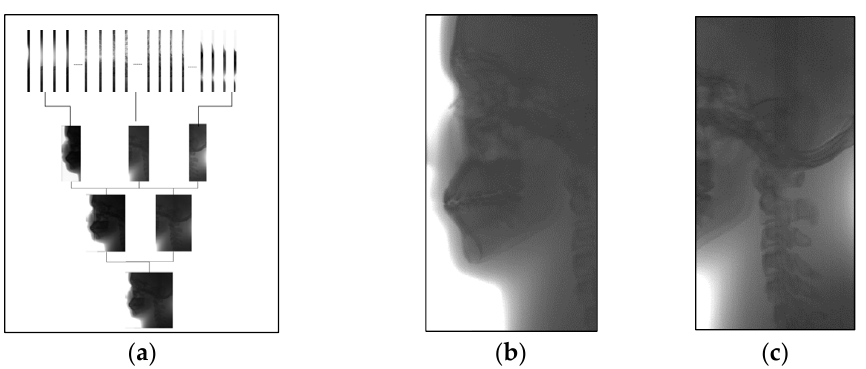
Figure 15. Stitching process of lateral cephalogram. ( a ) The image sequence is stitched in multiple rounds, ( b ) results of anterior skull stitching, ( c ) results of posterior skull stitching.